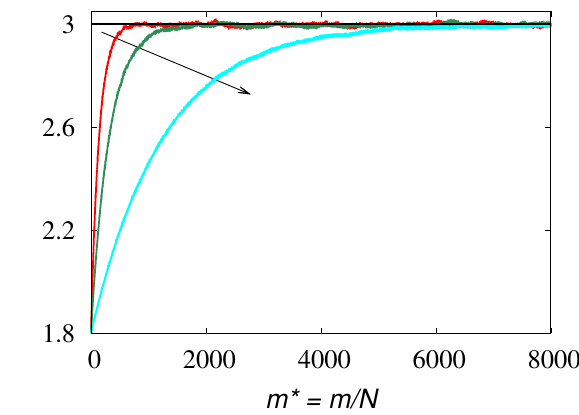
Figure 2. Kurtosis κ vs. m ∗ = m / N associated with the ensemble distribution of the first entry z h ,1 of z h iterating a CMT ( n = 2) with the dichotomic random perturbation Equations (17) and (18), discussed in the main text. The arrow indicates decreasing values of p = 3, 2,